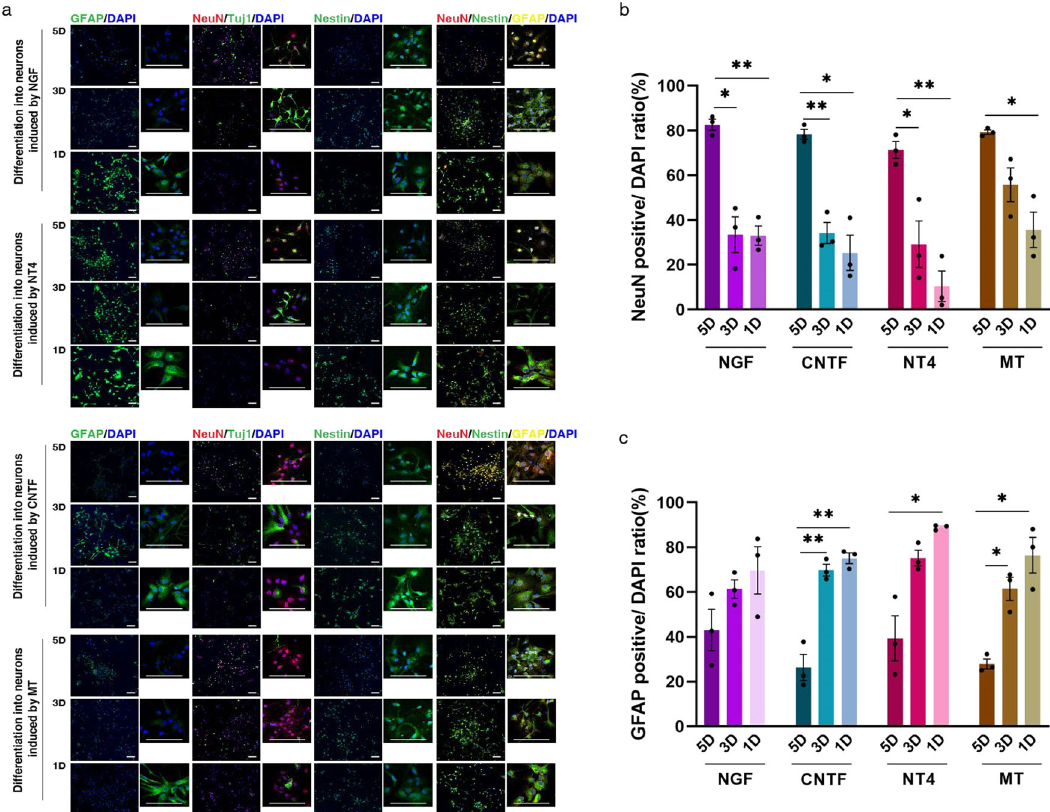
Fig. 3 Differentiation ef fi ciency of various neuron inducers, identi fi ed by immuno fl uorescence. a Images of immuno fl uorescence using NeuN, GFAP, Tuj1 and Nestin as characteristic markers of NGF/CNTF/NT4/MT-treated cells at 5D (5 days), 3D (3 days) and 1D (1 day). Quanti fi cation of immunostaining data. The y- axis shows the number of: b NeuN- and c GFAP-positive cells, n = 3 imaging fi eld repeats. Data are shown as mean ± SEM. Statistical signi fi cance was determined by two-sided Welch ’ s ANOVA. * p < 0.05, ** p < 0.01, *** p < 0.001. Scale bar = 100 μ